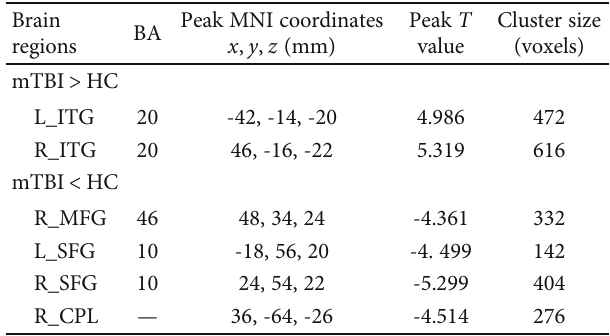
Table 1. Di ff erences in age, sex, and education level between groups were not signi fi cant (all p > 0 : 05 ). In this study, the